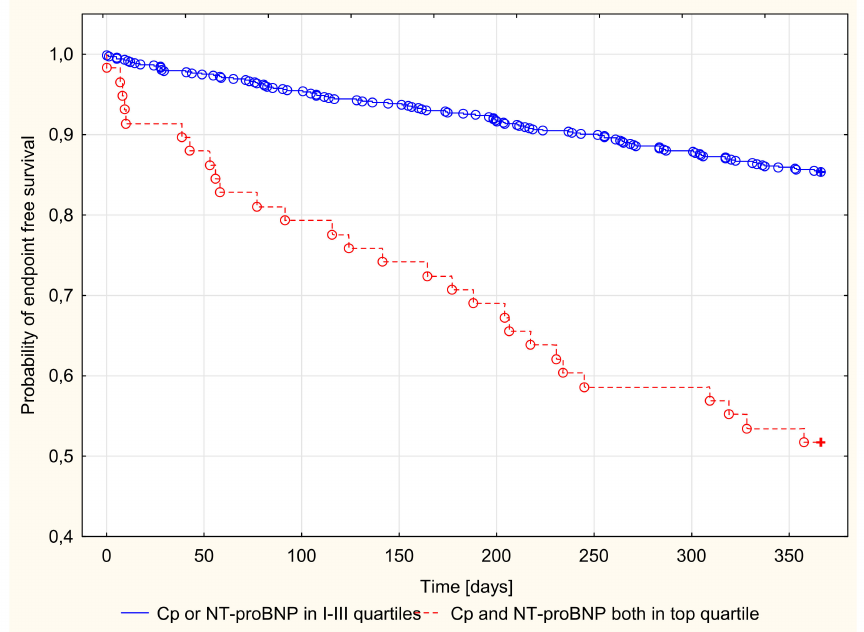
Figure 3. Probability of endpoint free survival in 1-year follow-up. Patients with Ceruloplasmin or NT-proBNP concentrations in I–III quartiles vs. both Cp and NT-proBNP in the top quartile, log rank p < 0.001.